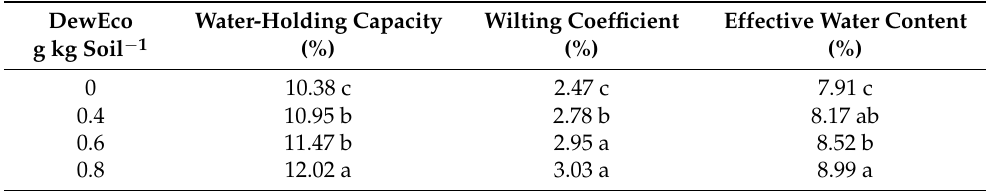
Table 4. Effects of different dosages of DewEco on soil water-holding capacity, wilting coefficient and effective soil water